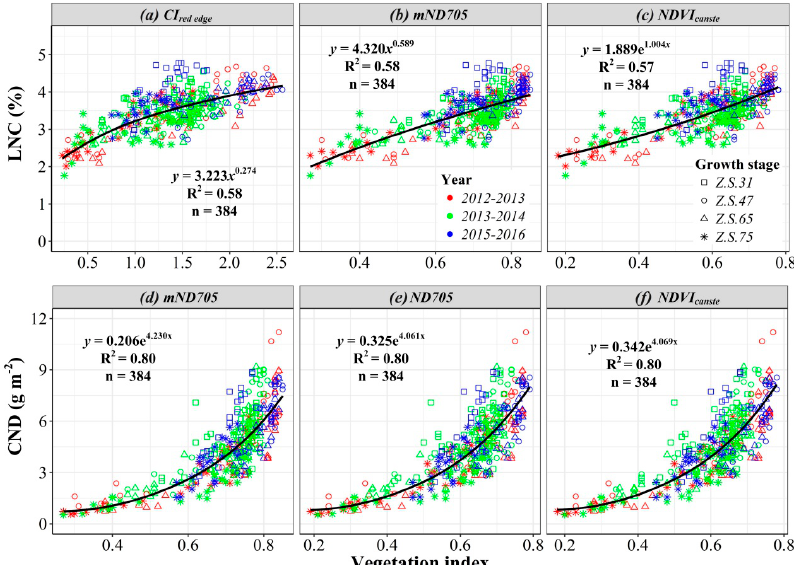
Figure 6. The best three regression models by vegetation index for LNC ( a – c ) and CND ( d – f ) estimation in winter wheat across the calibration set ( n = 384). in winter wheat across the calibration set ( n =